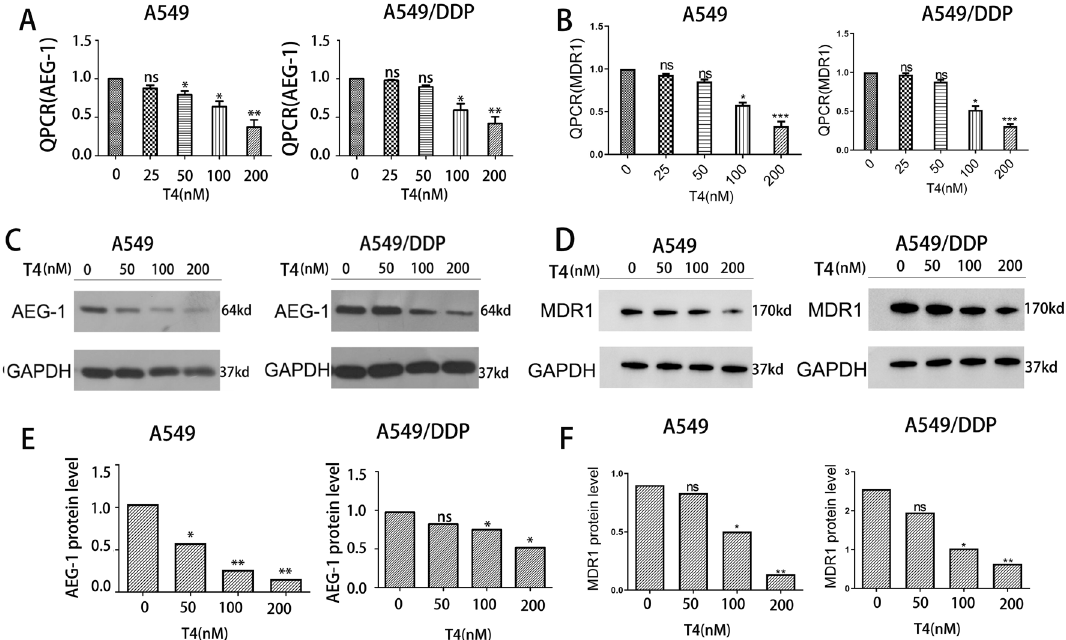
Figure 3. The effect of T4 on regulating AEG-1 expression. ( A , B ) The mRNA expression of AEG-1 and MDR-1 in T4, A549 and A549/DDP cells. ( C , D ) The protein expression of AEG-1 and MDR-1 in T4, A549 and A549/